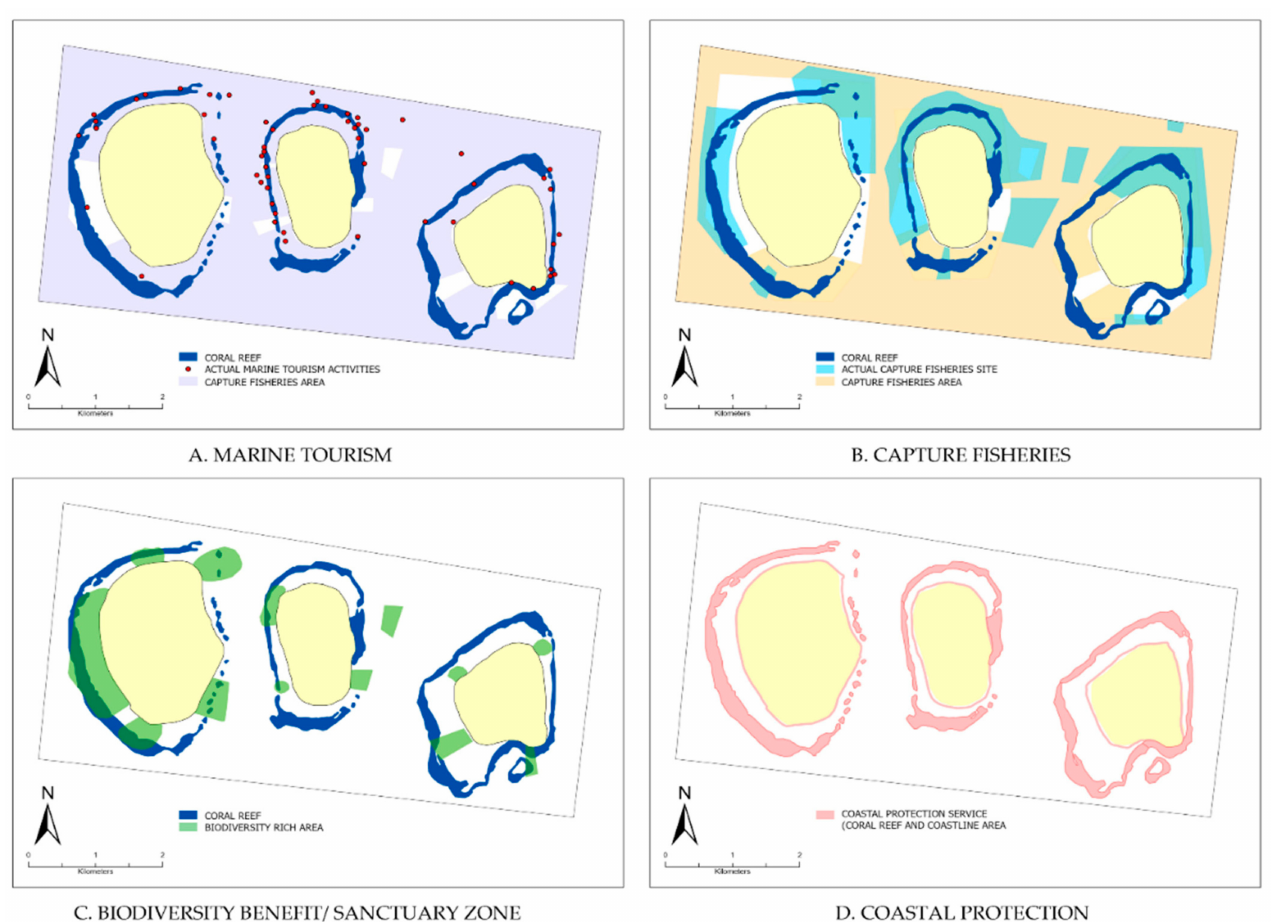
Figure 5. The location of key ecosystem services at the GMMTP coral reef: ( A ) Marine Tourism; ( B ) Capture Fisheries; ( C ) Biodiversity Benefit/Sanctuary Zone (Supporting Services), and; ( D ) Coastal Protection (Regulating